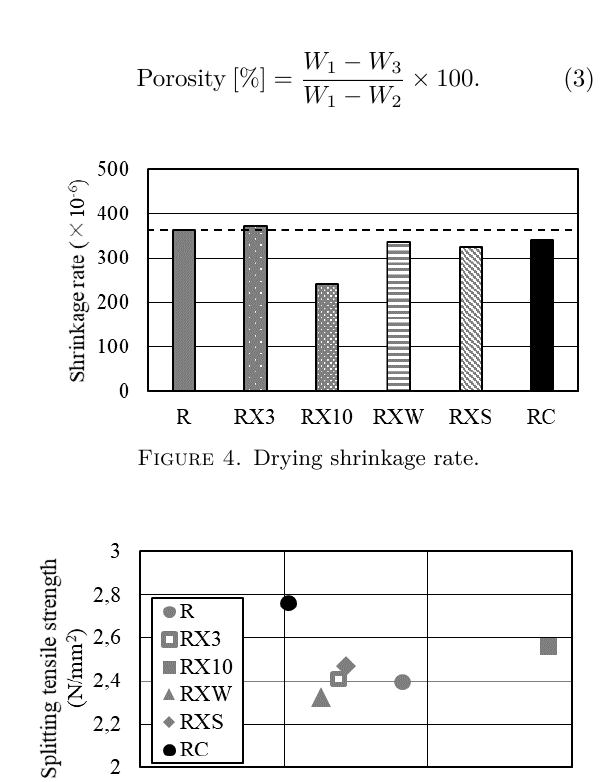
Figure 7. Compressive strength and air permeability coe ffi cient.